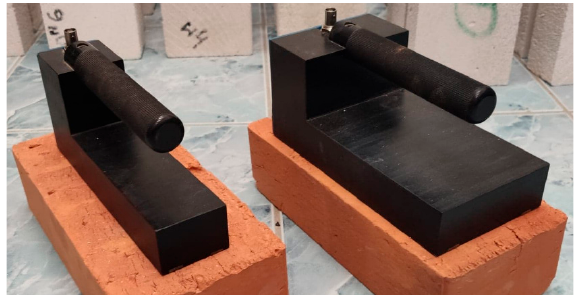
Figure 2. Photograph of non-invasive TDR sensors—Sensor A ( left ), Sensor B ( right ).